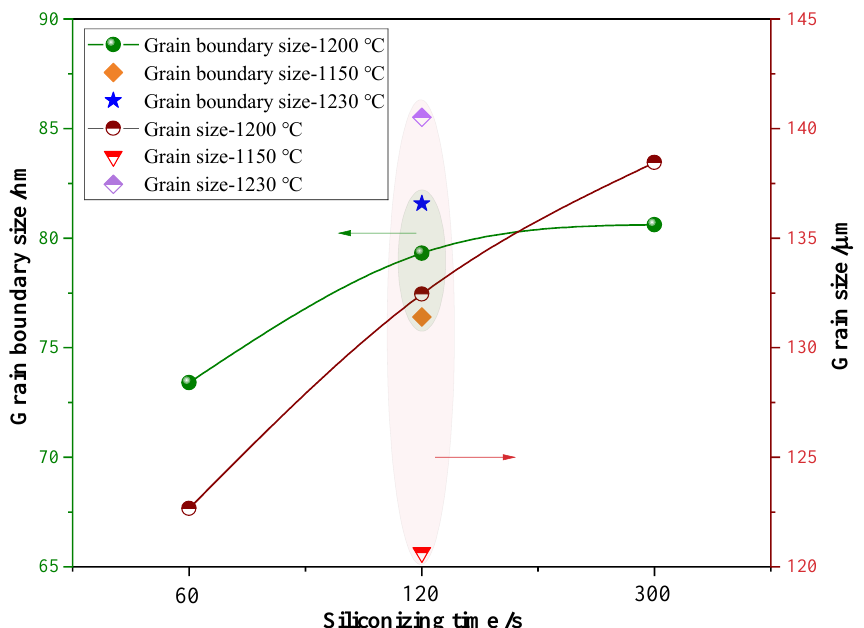
Figure 6. Grain and grain boundary size after silicon permeation at different temperatures and times: Green arrows indicate grain boundary size and red arrows indicate grain size.